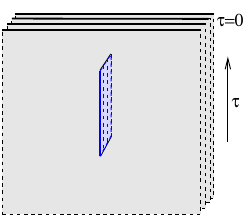
JHEP03(2021)167